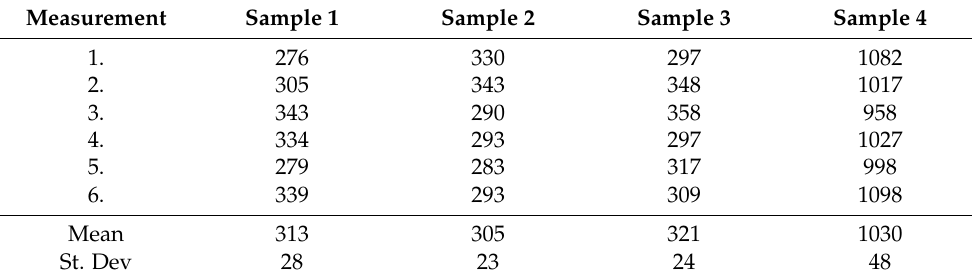
Table 2. Microhardness HV1 of the